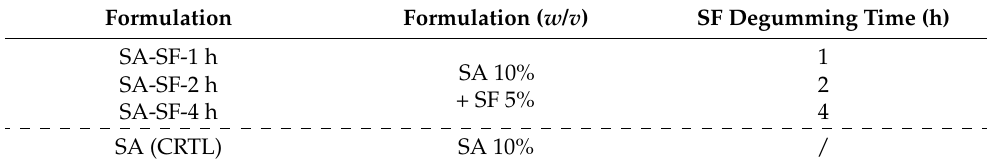
Table 2. Overview of hydrogel formulations. SA: sodium alginate, SF: silk fibroin, CRTL: control. Formulation Formulation ( w / v ) SF Degumming Time (h) SA-SF-1 h 1 SA 10% SA-SF-2 h 2 + SF 5% SA-SF-4 h 4 SA (CRTL) SA 10%